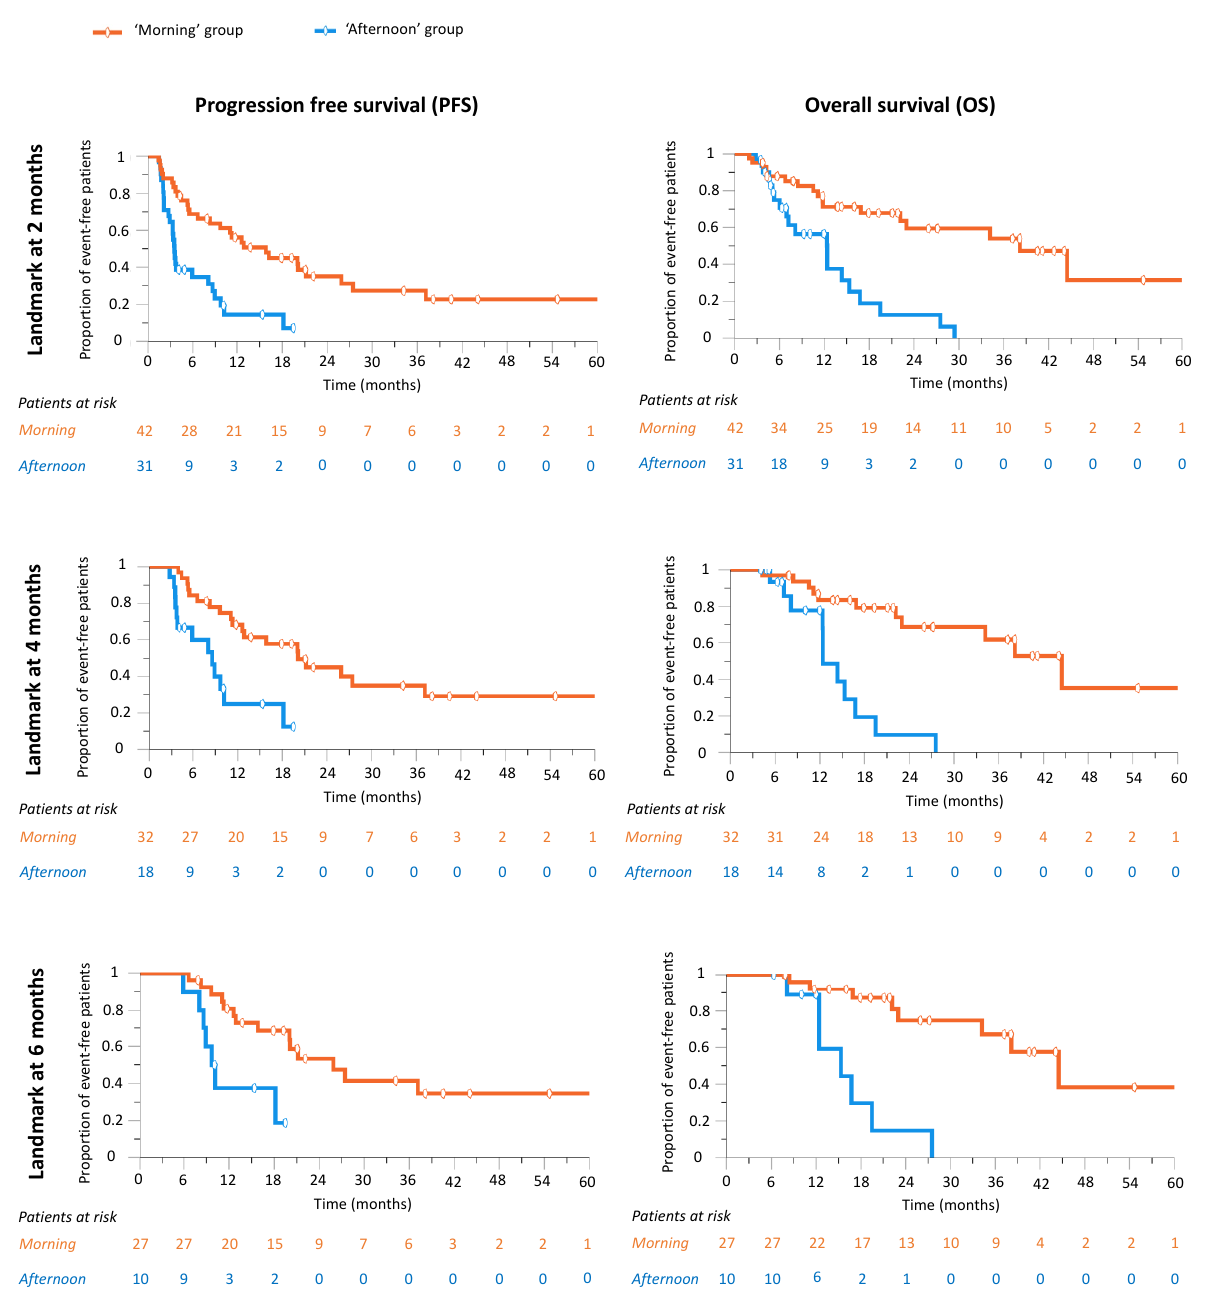
months (6.2 – 25.5), whereas it was 3.5 months (3.2 – 3.9) for the 31 patients in the ‘afternoon’ group with the same nivolumab exposure ( p < 0.001) (Figure 3). Similar results were ob- tained at the 4-month and 6-month landmark analyses (Figure 3). These findings indicated that nivolumab timing was critical for efficacy from the very beginning of treatment ad- ministration, and that the duration of tumor control by immunotherapy was critical for OS.